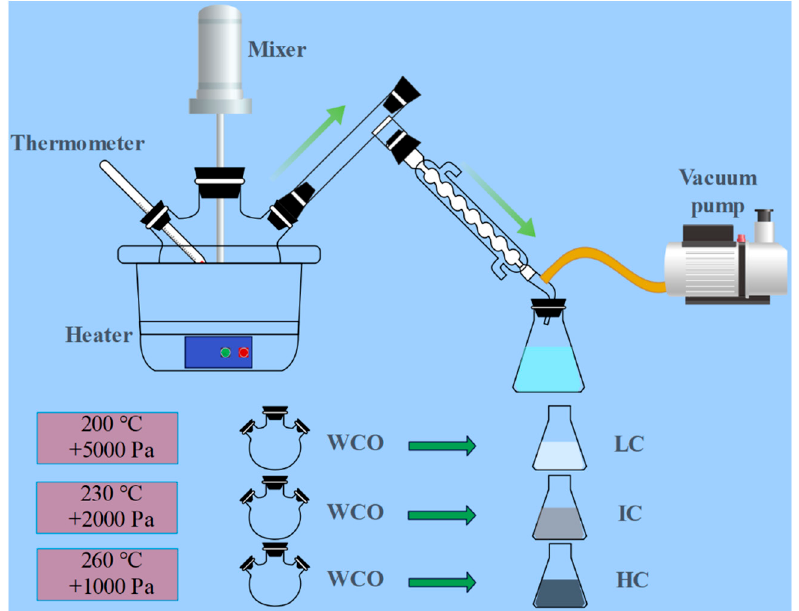
Figure 1. Schematic diagram of laboratory extraction of different compositions of WCO.